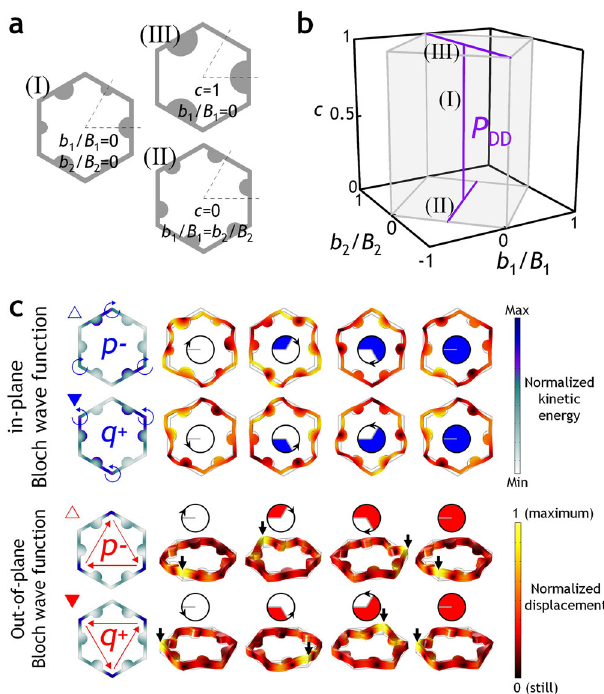
Fig. 2 Manifestation of deterministic Dirac degeneracy and degenerated states. a Three conditions [(I), (II), and (III)] and associated schematics of primitive cells individually guaranteeing the deterministic Dirac degeneracy at K or K ′ for the phononic crystals (PCs). b Parameters (solid violet lines) of the PCs satisfying conditions (I), (II), or (III), or equivalently, having deterministic Dirac degeneracy at K or K ′ in the restricted parameter space (volume enclosed by gray solid lines). P DD indicates the set of all such parameters. The complete parameter space is described in Supplementary Note 1. c Energy distributions and displacement fi elds of a primitive cell of the PC with parameter (0, 0, 0) at the in-plane polarized (IPP) and out-of- plane polarized (OPP) Dirac degeneracies at K point. Arrows on the energy distribution, blue for IPP, and red for OPP wave show the rotation direction of the motion. Four displacement fi elds taken at one-third of a period interval show the time-varying motion of the degenerated state; top view presents for IPP states and perspective view presents present for OPP states, and black arrow in OPP displacement fi eld points to the displacement maxima. The black circle and arrow associated with each displacement fi eld show the direction of the motion as well as the phase step. Characters ( p − or q + ) and triangular symbols are a shorthand representation of the state; moving sublattices (location of moving sublattices) and signs ( fi ll) indicating the rotation direction are used for characters (symbols), and colored blue for IPP and red for OPP